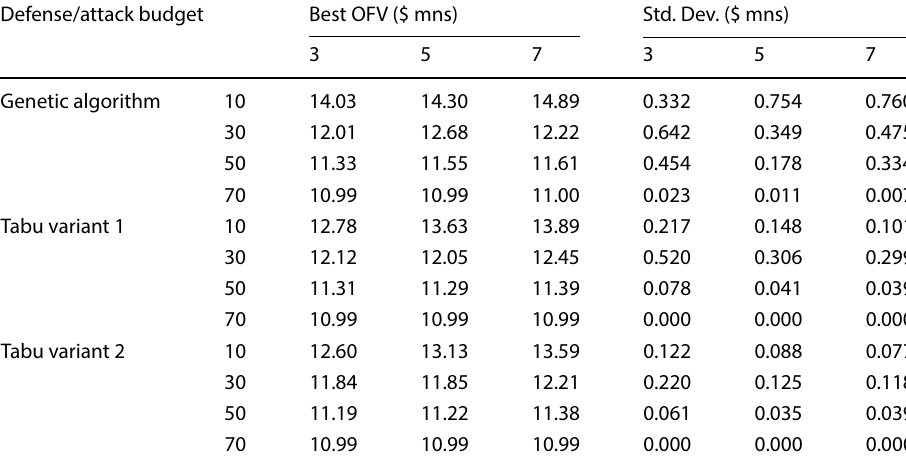
Table 2 Comparing the two variants of tabu search algorithm